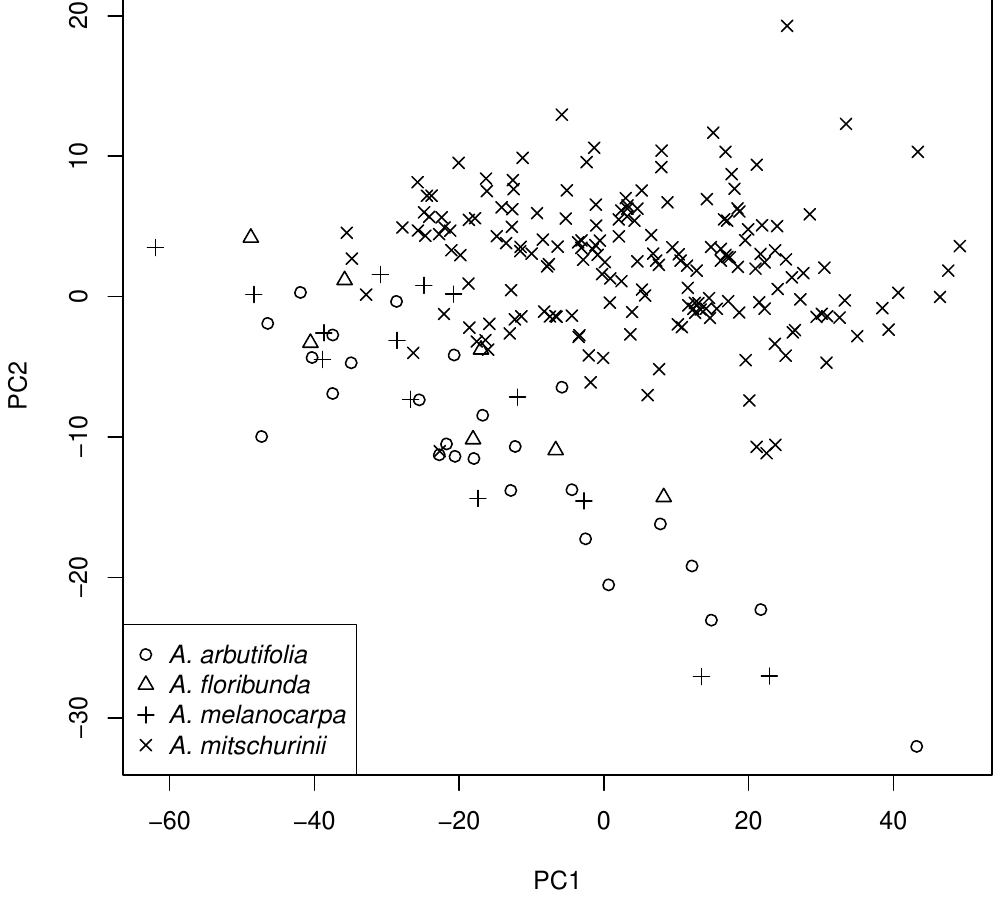
Fig. 5. Ordination on the plane of first two principal components from the analysis of morphological